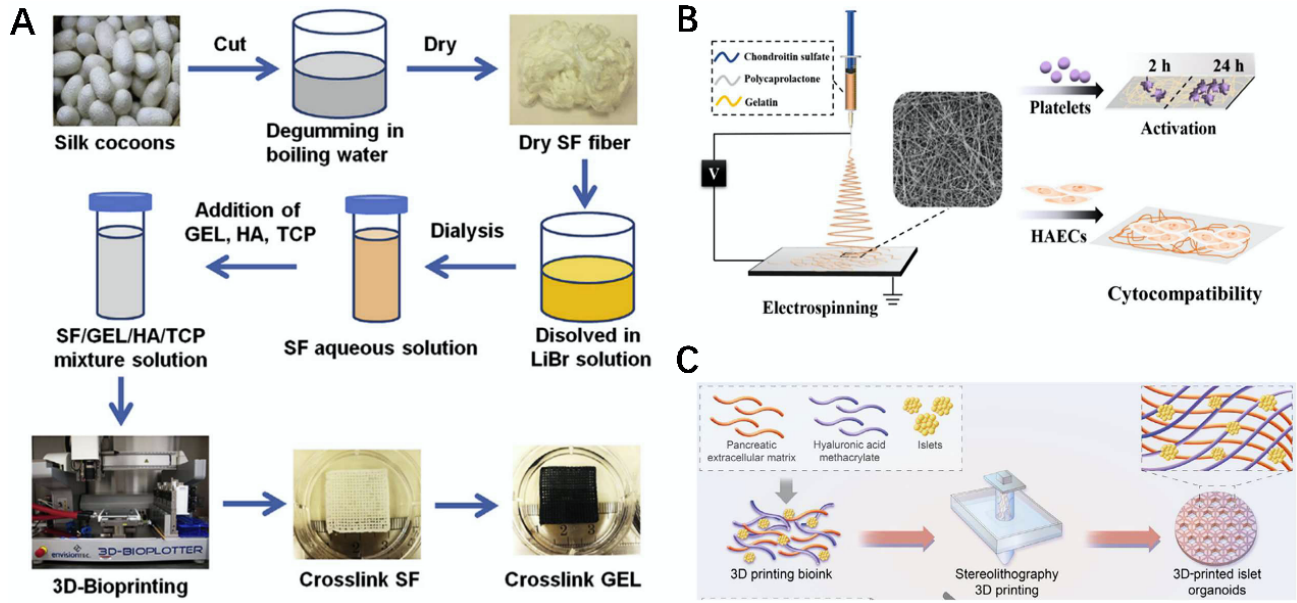
Figure 10. Schematic representation of the preparation of bio-scaffolds, nanofibers, and hydrogels using related natural materials. ( A ) Schematic diagram of SF scaffold prepared via 3D printing technology [166]. ( B ) Schematic representation of the preparation of CS–gelatin–PCL composite nanofibers [167]. ( C ) Schematic diagram of a hydrogel printed using HAMA/pECM bio-ink [168].